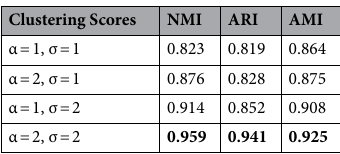
Table 1. Clustering scores set experimental parameters. Significant values are in